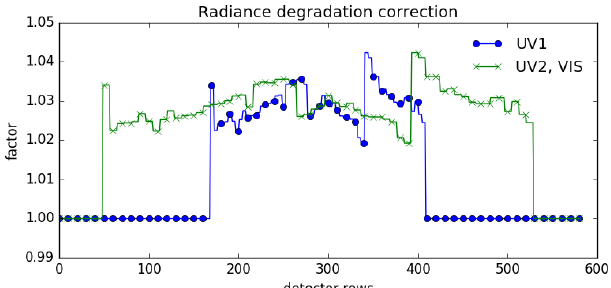
Figure 12. Radiance degradation correction factor (multiplicative) for orbit 100000 as a function of the detector rows for the UV1, UV2, and VIS